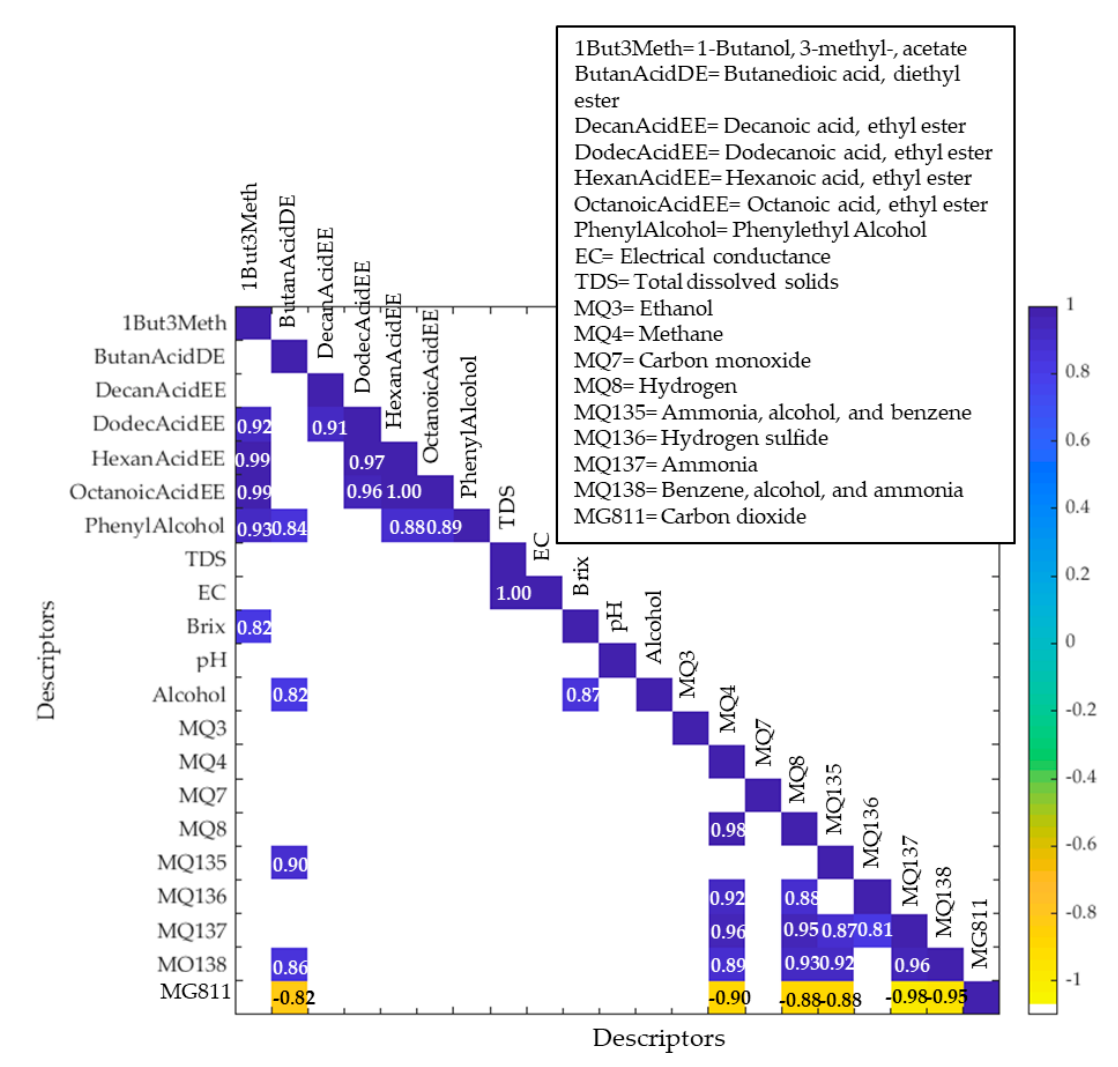
Figure 4. Matrix showing the significant ( p < 0.05) correlations between the chemical measurements, volatile aroma compounds and e-nose readings. Color bar: the blue side depicts the positive correlations, while the yellow side depicts the negative correlations. Darker blue and yellow colors denote higher correlations.